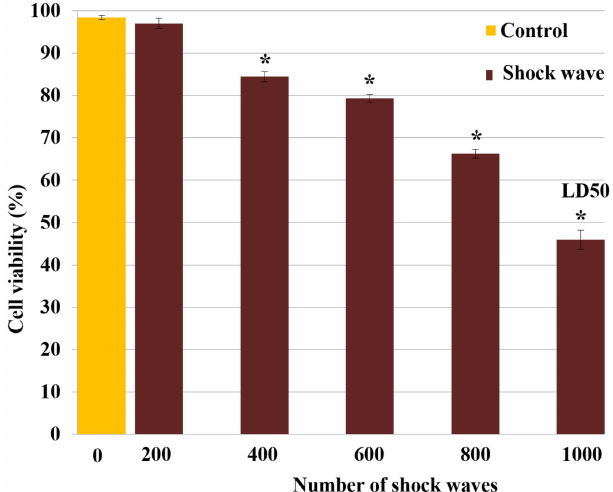
Figure 2. Shock wave cytotoxicity for TOS-1 renal cell carcinoma. The cell viability was measured by trypan blue exclusion test after exposure to different shock wave (SW) numbers of 200, 400, 600, 800 or 1000. A lethal dose of 50% (LD 50 ) was obtained with 1000 SW exposures. Each data point represents mean ± SD ( n = 3), * p < 0.05, compared with the